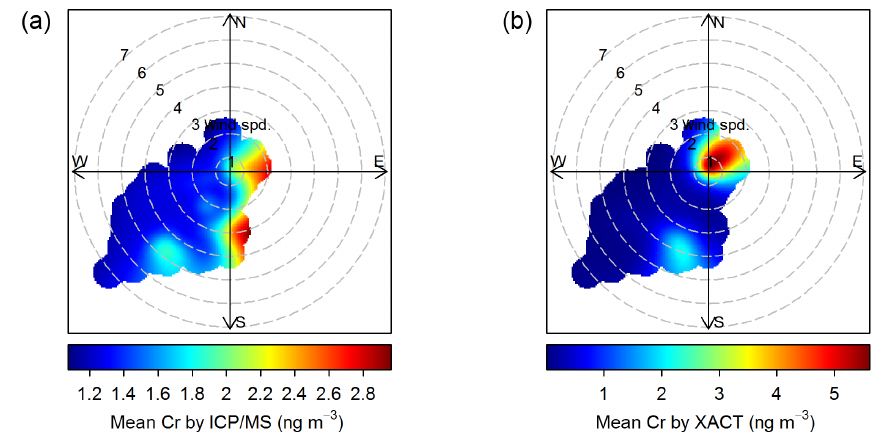
Figure 4. Polar plot of the Cr concentrations (ngm − 3 ) in Pontardawe, Wales using daily ICP-MS measurements (a) and hourly XACT measurements (b) . Table 7. Deming regression results and coefficient of determination for XACT comparison with ICP-MS, separated by HF / HClO 4 and HNO 3 / H 2 O 2